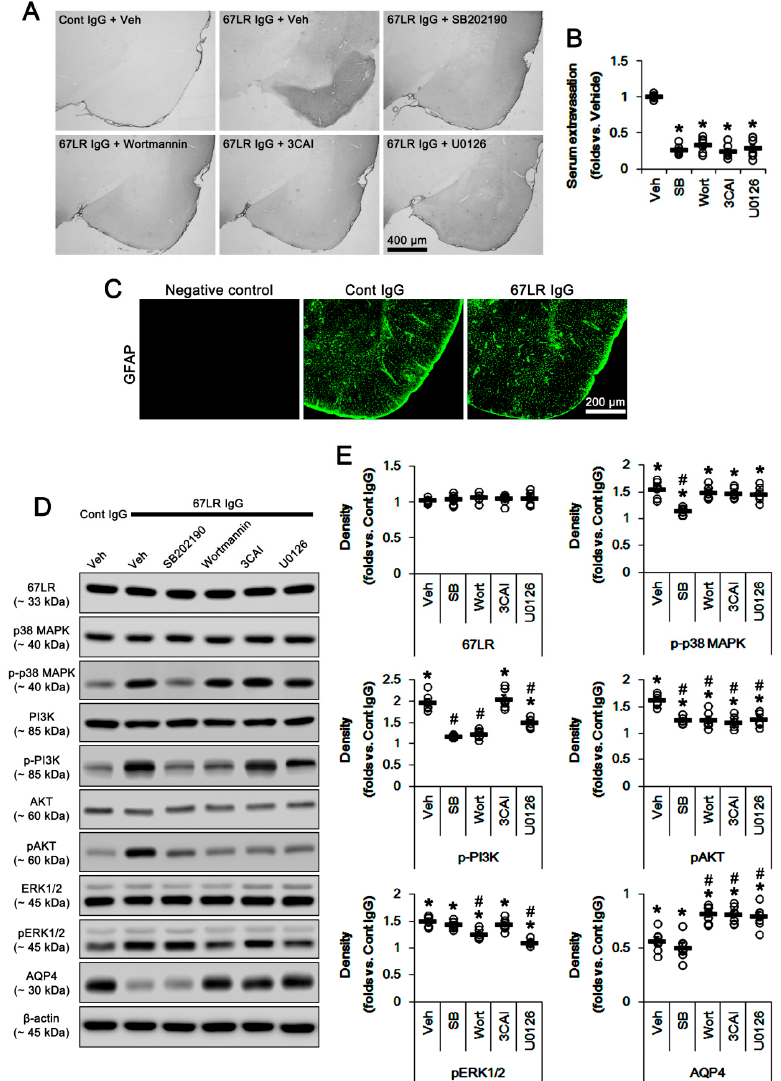
Figure 2. E ff ects of kinase inhibitors on serum extravasation, protein phosphorylations, and AQP4 expression in the PC following control IgG (Cont IgG) and 67LR neutralization (67LR IgG). 67LR IgG infusion does not evoke astroglial degeneration in the PC. Although 67LR IgG infusion does not change 67LR expression level, 67LR neutralization leads to the up-regulation of p-p38 MAPK, pPI3K-Y458, pAKT-T308, and pERK1 / 2 level. However, 67LR IgG infusion reduces AQP4 expression. SB202190 co-treatment attenuates serum extravasation and phosphorylations of p38 MAPK and PI3K / AKT, but not pERK1 / 2 and AQP4 levels. Wortmannin, 3CAI, and U0126 diminish serum extravasation. Wortmannin and U0126 inhibit the increased p-PI3K / AKT and pERK1 / 2 levels. 3CAI ameliorates only pAKT levels. Wortmannin, 3CAI, and U0126 increase the AQP4 expression level without a ff ecting p38 MAPK phosphorylation. ( A ) Representative photographs for serum extravasation in the PC. (B ) Quantitative values (mean ± S.E.M) of serum extravasation SE ( n = 7, respectively). Open circles indicate each individual value. Horizontal bars indicate the mean value. Error bars indicate S.E.M. Significant di ff erences are * p < 0.05 vs. vehicle (one-way ANOVA). ( C ) Representative photographs of GFAP expression in the PC. ( D ) Representative Western blot images for expressions and phosphorylations of 67LR, p38 MAPK, PI3K, AKT, ERK1 / 2, and AQP4. ( E ) Quantitative values (mean ± S.E.M) of the Western blot data concerning expressions and phosphorylations of 67LR, p38 MAPK, PI3K, AKT, ERK1 / 2, and AQP4 ( n = 7, respectively). Open circles indicate each individual value. Horizontal bars indicate the mean value. Error bars indicate S.E.M. Significant di ff erences are * ,# p < 0.05 vs. control IgG and vehicle, respectively (one-way